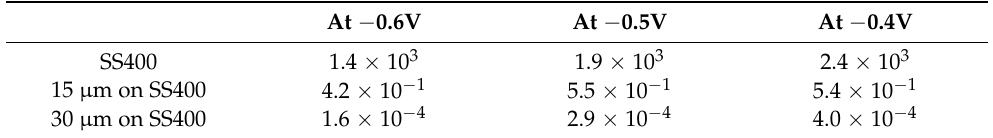
Table 1. Simple evaluation of sulfuric acid permeation through the films estimated from the corrosion current at active state from − 0.6 to − 0.4 V.